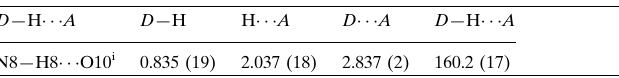
Hydrogen-bond geometry (A˚ , (cid:1)